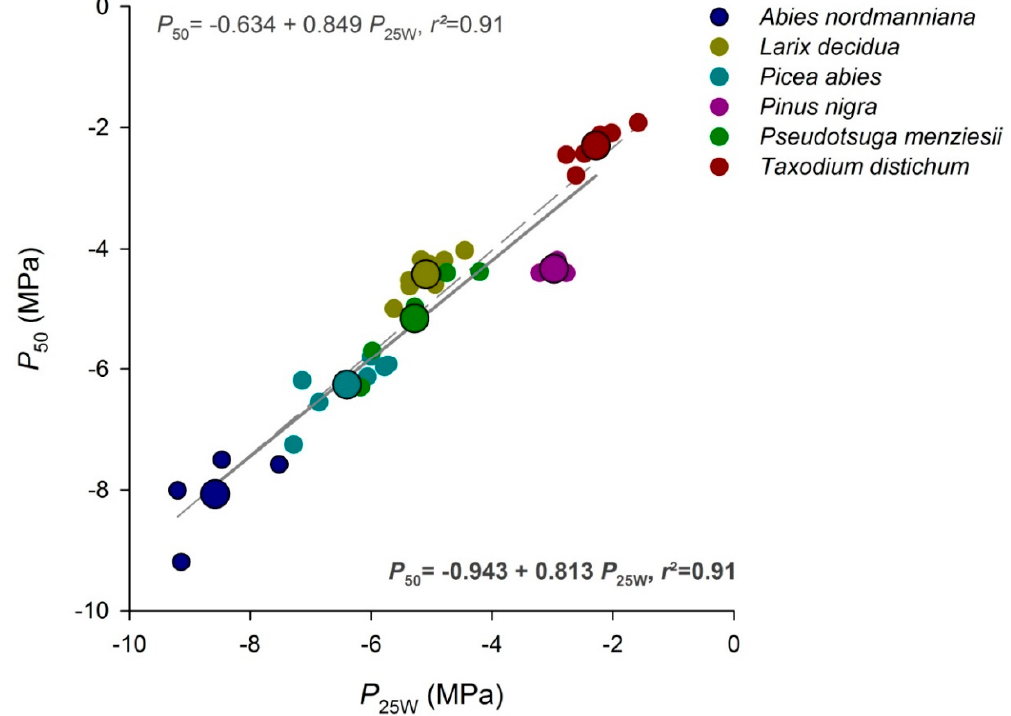
Figure 3. Relationships between P 50 (water potential resulting in 50% conductivity loss) and P 25W (water potential resulting in 25% relative water loss) of six different conifer species. Small dots indicate single tree or branch samples; big dots species mean values. Hatched lines are linear regression lines for single tree or branch samples, solid lines are linear regression lines for species mean values.